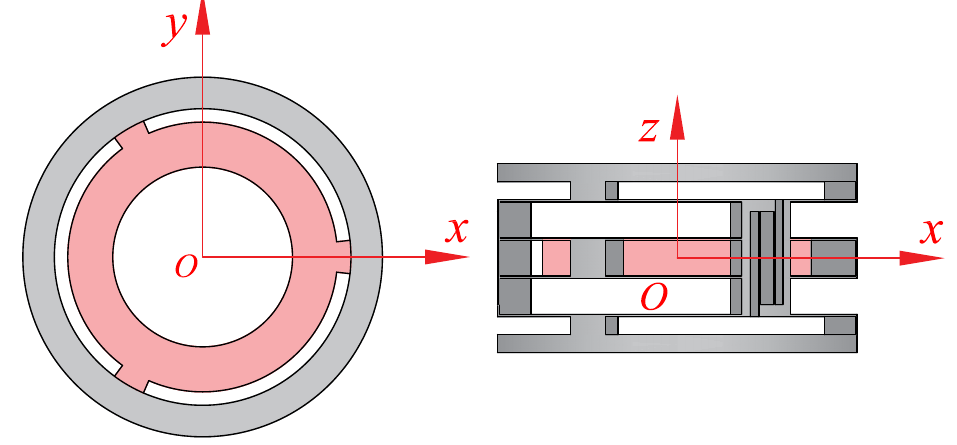
Figure 5. The defined coordinate